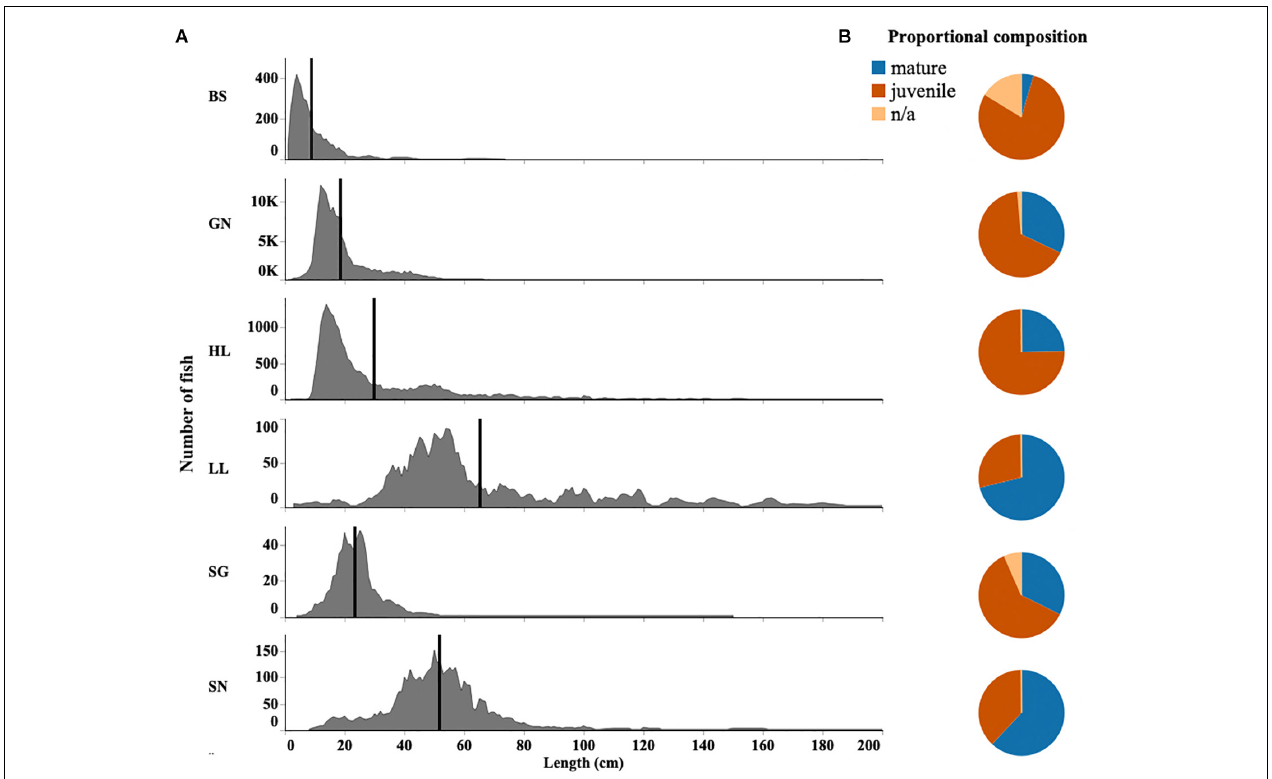
FIGURE 5 | (A) Fish length distribution for each gear type (BS, Beach seine; GN, Gill net; HL, Handline; HS, Hand-spear; LL, Longline; SG, Spear-gun; SN, Shark net), black line indicates the mean length. (B) Proportion of juvenile and mature fish within sampled catches of each gear type. Fish length distributions for the top 10 most abundant species are given in Supplementary Figure S2